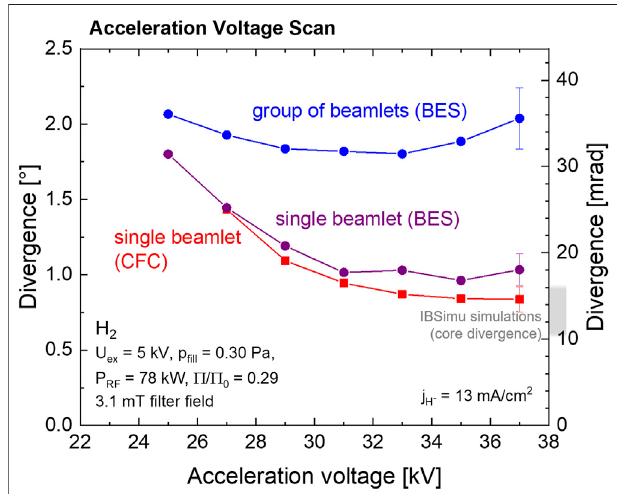
FIGURE 9 | Horizontal divergence measured at BUG for a group of beamlets(usingBES)andanisolated,singlebeamlet(usingBESandthemini- STRIKE CFC tile calorimeter) as a function of the applied acceleration voltage [56].TheexpectedminimumofthecoredivergencepredictedbyIBSimu is indicated as